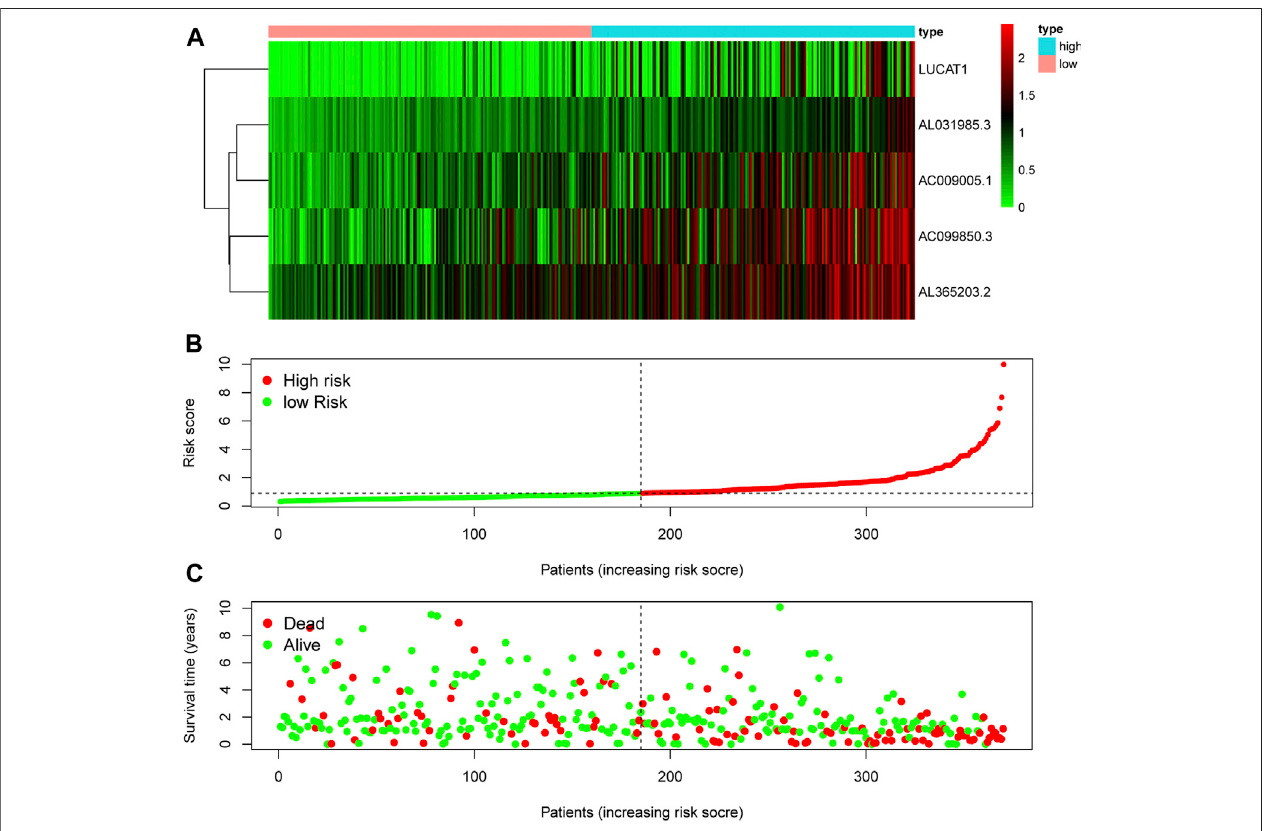
FIGURE 3 | Evaluation of the ferroptosis-related lncRNA signature for prognostic prediction. (A) The expression pattern of fi ve ferroptosis-related lncRNAs in low- and high-risk groups of HCC patients. (B) The risk score of each patient, showing grouping into low- and high-risk groups. (C) The relationship between OS and risk score for each patient. lncRNA: long noncoding RNA; OS: overall